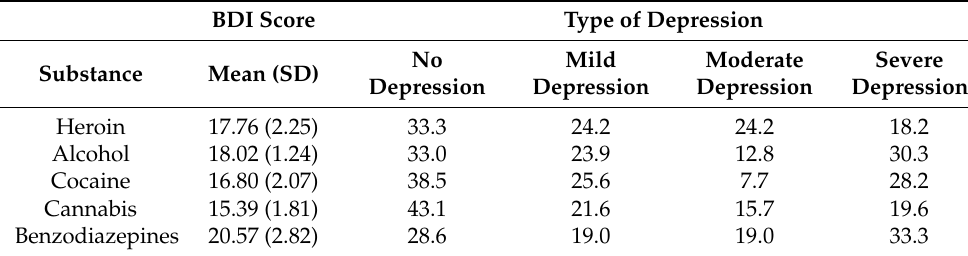
Table 1. Percentage of consumers of psychoactive substances depending on the types of depression.